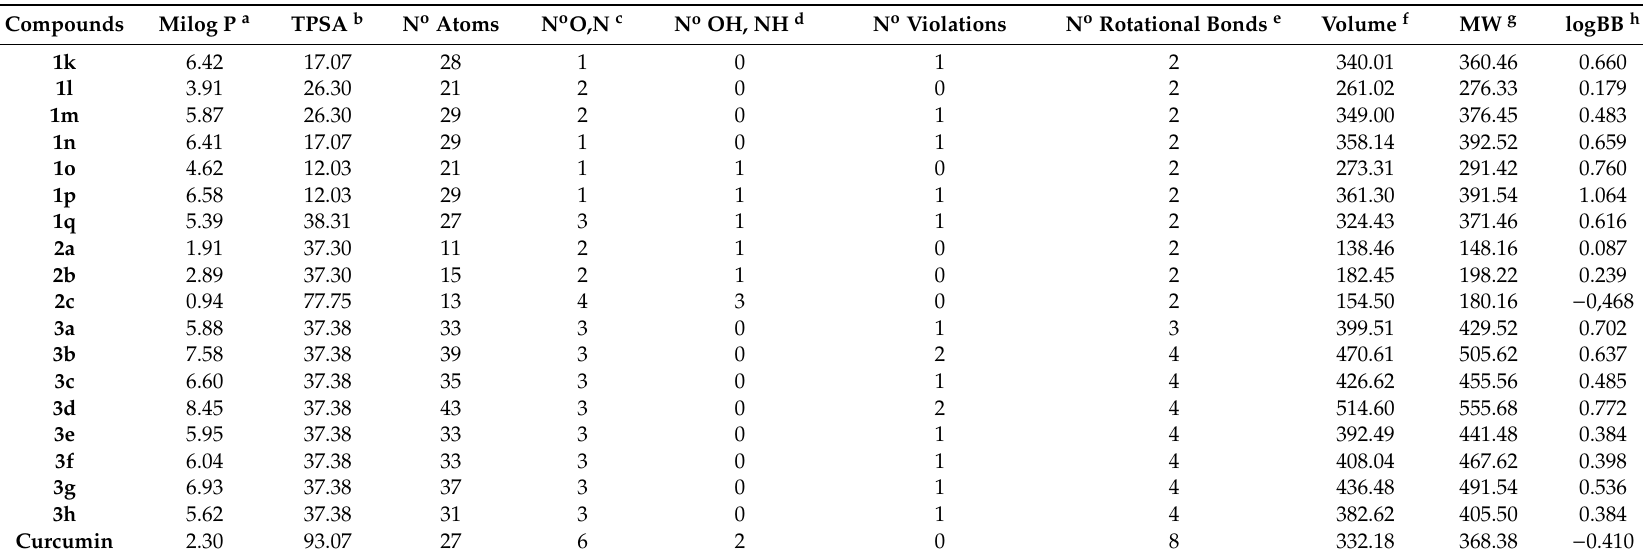
Table 2. Molecular properties prediction—Lipinski’s Rule of